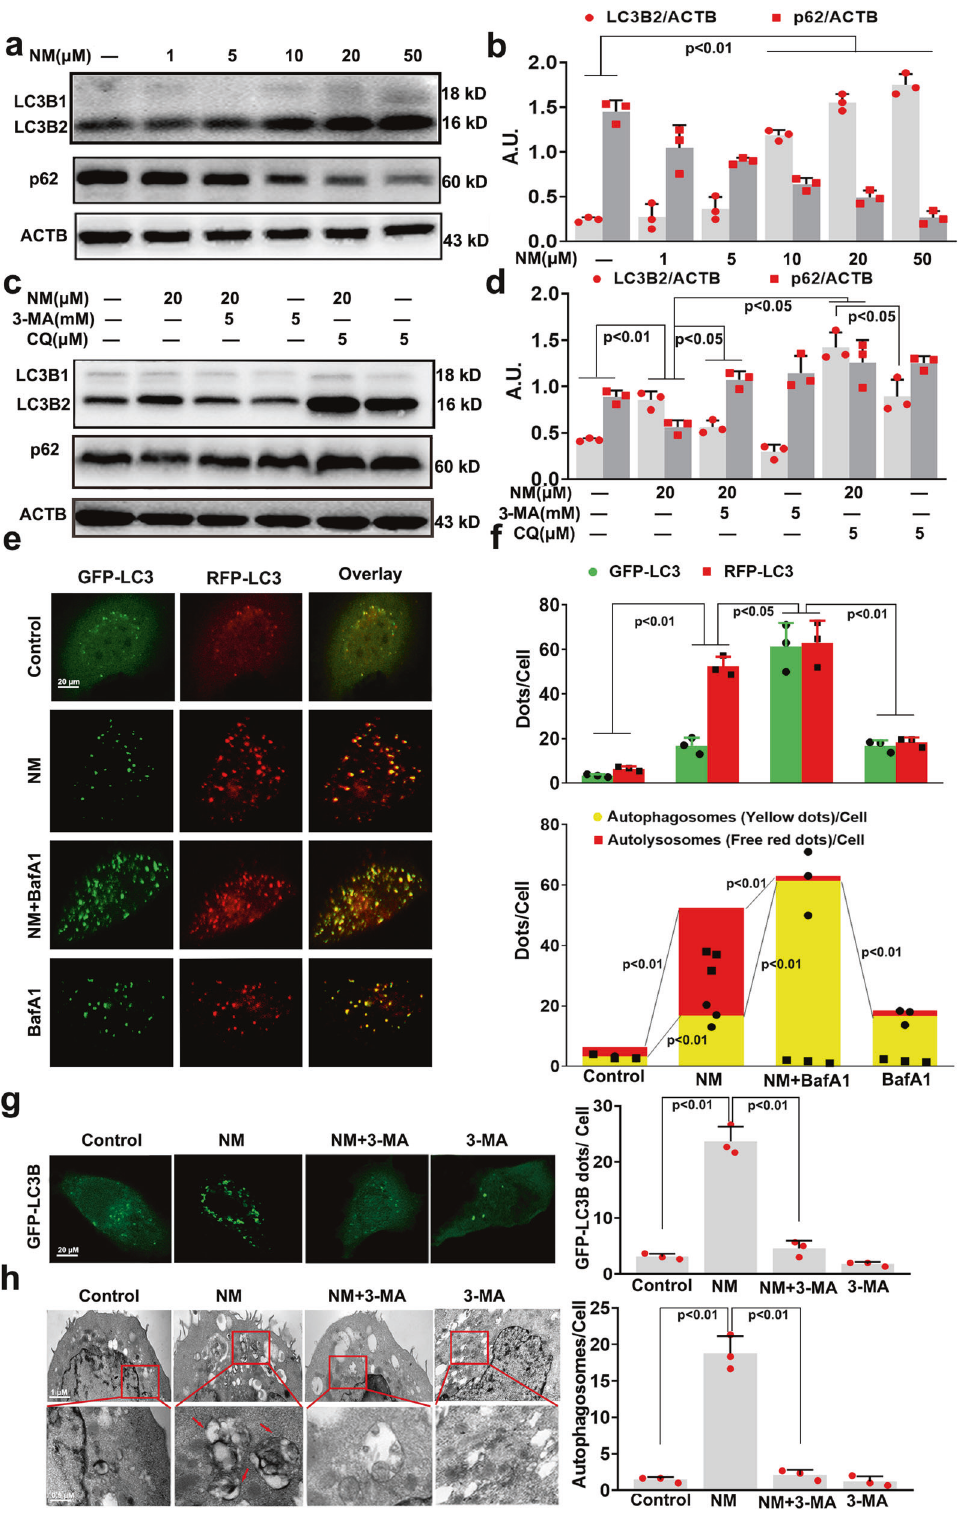
which then decreased in the presence of 3-MA (Fig. 2g). Moreover, transmission electron microscopy, the most valid method for both qualitative and quantitative analysis of autophagy, 22 showed that more vacuoles were present in NM-treated keratinocytes, but the number decreased when the cells were pretreated with